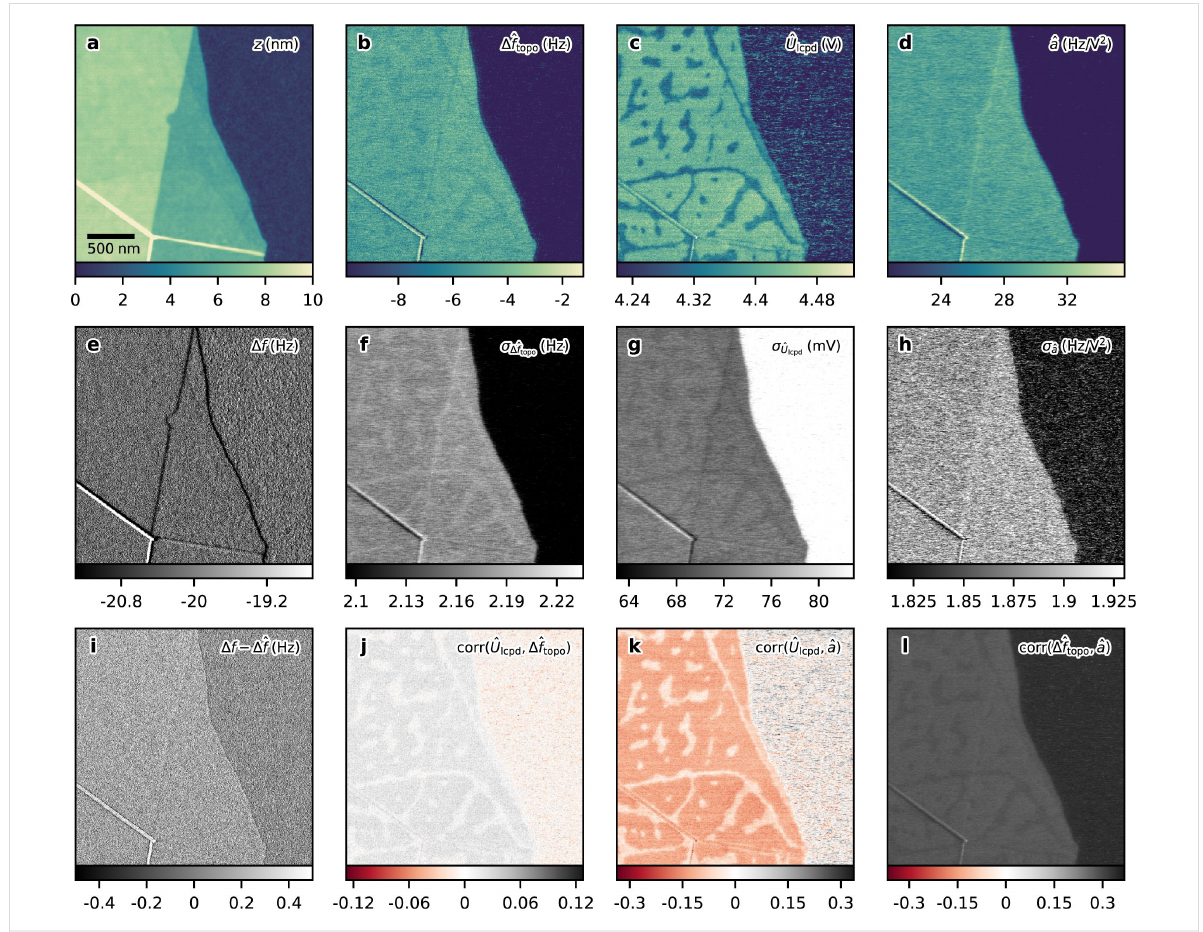
Figure 3: Open-loop TD-KFM of a few-layer graphene flake. (a) Topography, (b) estimated topography-induced frequency shift , (c) estimated surface potential , and (d) estimated coefficient . (e) The frequency shift Δ f was kept constant at − 20 Hz by the topography feedback. (f–h) and (j–l) show the variance and mutual correlations of the estimated states, respectively. (i) Residual of the estimation. Parameters: U ac = 1 V, U dc = 4.3 V, f m = 500 Hz, f s = 3.6 kHz, PLL bandwidth: 1.5 kHz, R th = 1.55 × 10 − 3 Hz 2 Hz − 1 , Q topo = 4800 Hz 2 Hz, Q lcpd = 10 V 2 Hz, Q a = 400 Hz 2 V − 4 Hz; Detection noise R D ≪ R th is neglected here. Tip: Olympus AC240TM-R3, A = 14 nm, k = 2.3 N m − 1 , f 0 = 71.04 kHz, Q = 134, v scan = 2.5 μ m s − 1